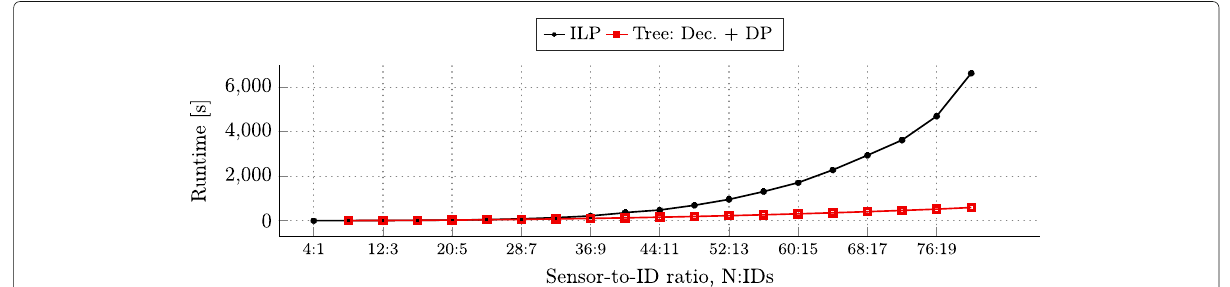
Fig. 11 Run-time simulation for a fixed sensor-to-ID ratio of 4 : 1, starting with 4 agents and 1 ID and ending with 80 agents and 20 IDs. The measurement noise has been set to σ = 0.05